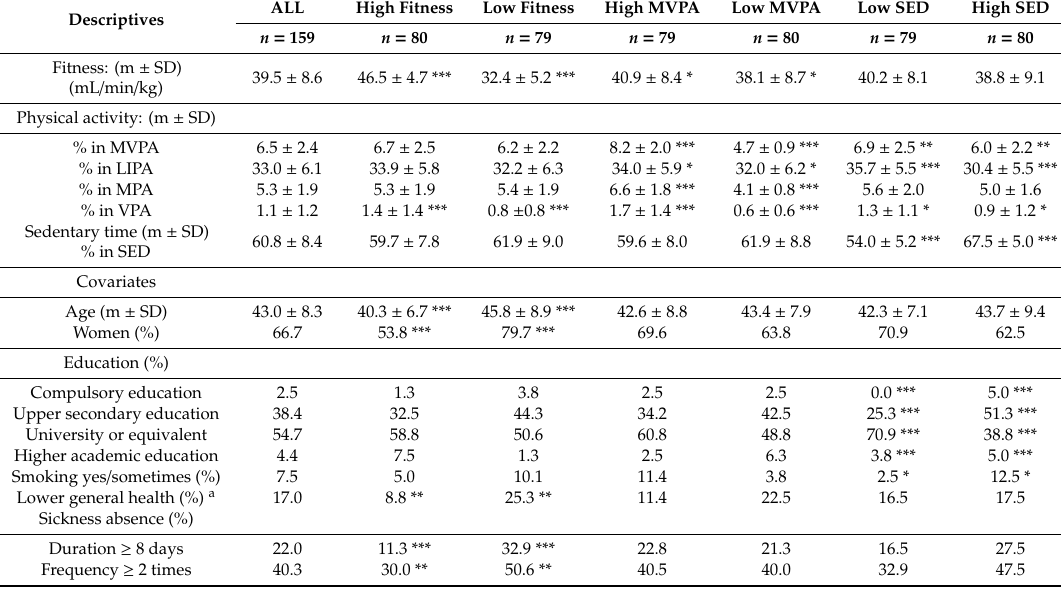
Table 1. Characteristics of the sample, stratified by fitness, MVPA, and sedentary time status. Statistical di ff erences between the mean variables were examined using MANOVA for continuous variables and chi-square tests for the categorical variables ( n =